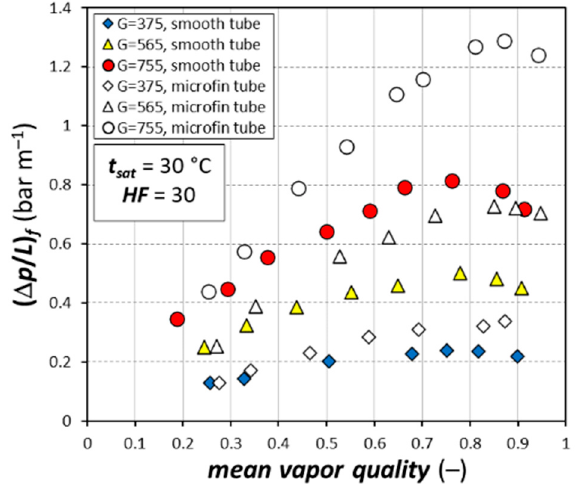
Figure 8. Comparison between frictional pressure gradient of smooth tube and microfin tube. Data at t sat = 30 °C and HF = 30 kW m − 2 at different mass velocity. G expressed in (kg m − 2 s − 1 ). Data for the microfin tube are borrowed by Diani et al. [21].